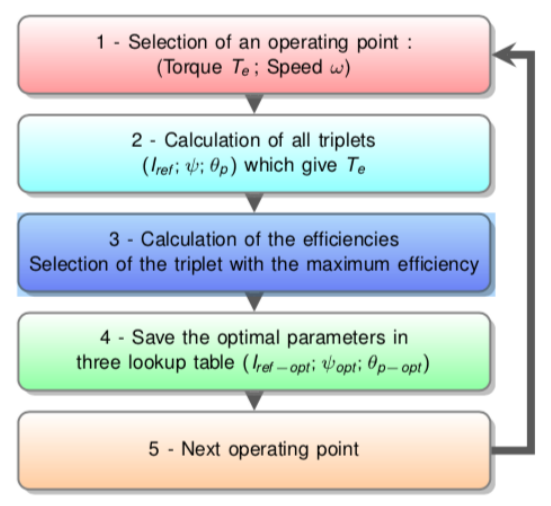
Figure 10. Flowchart of the parametric method.